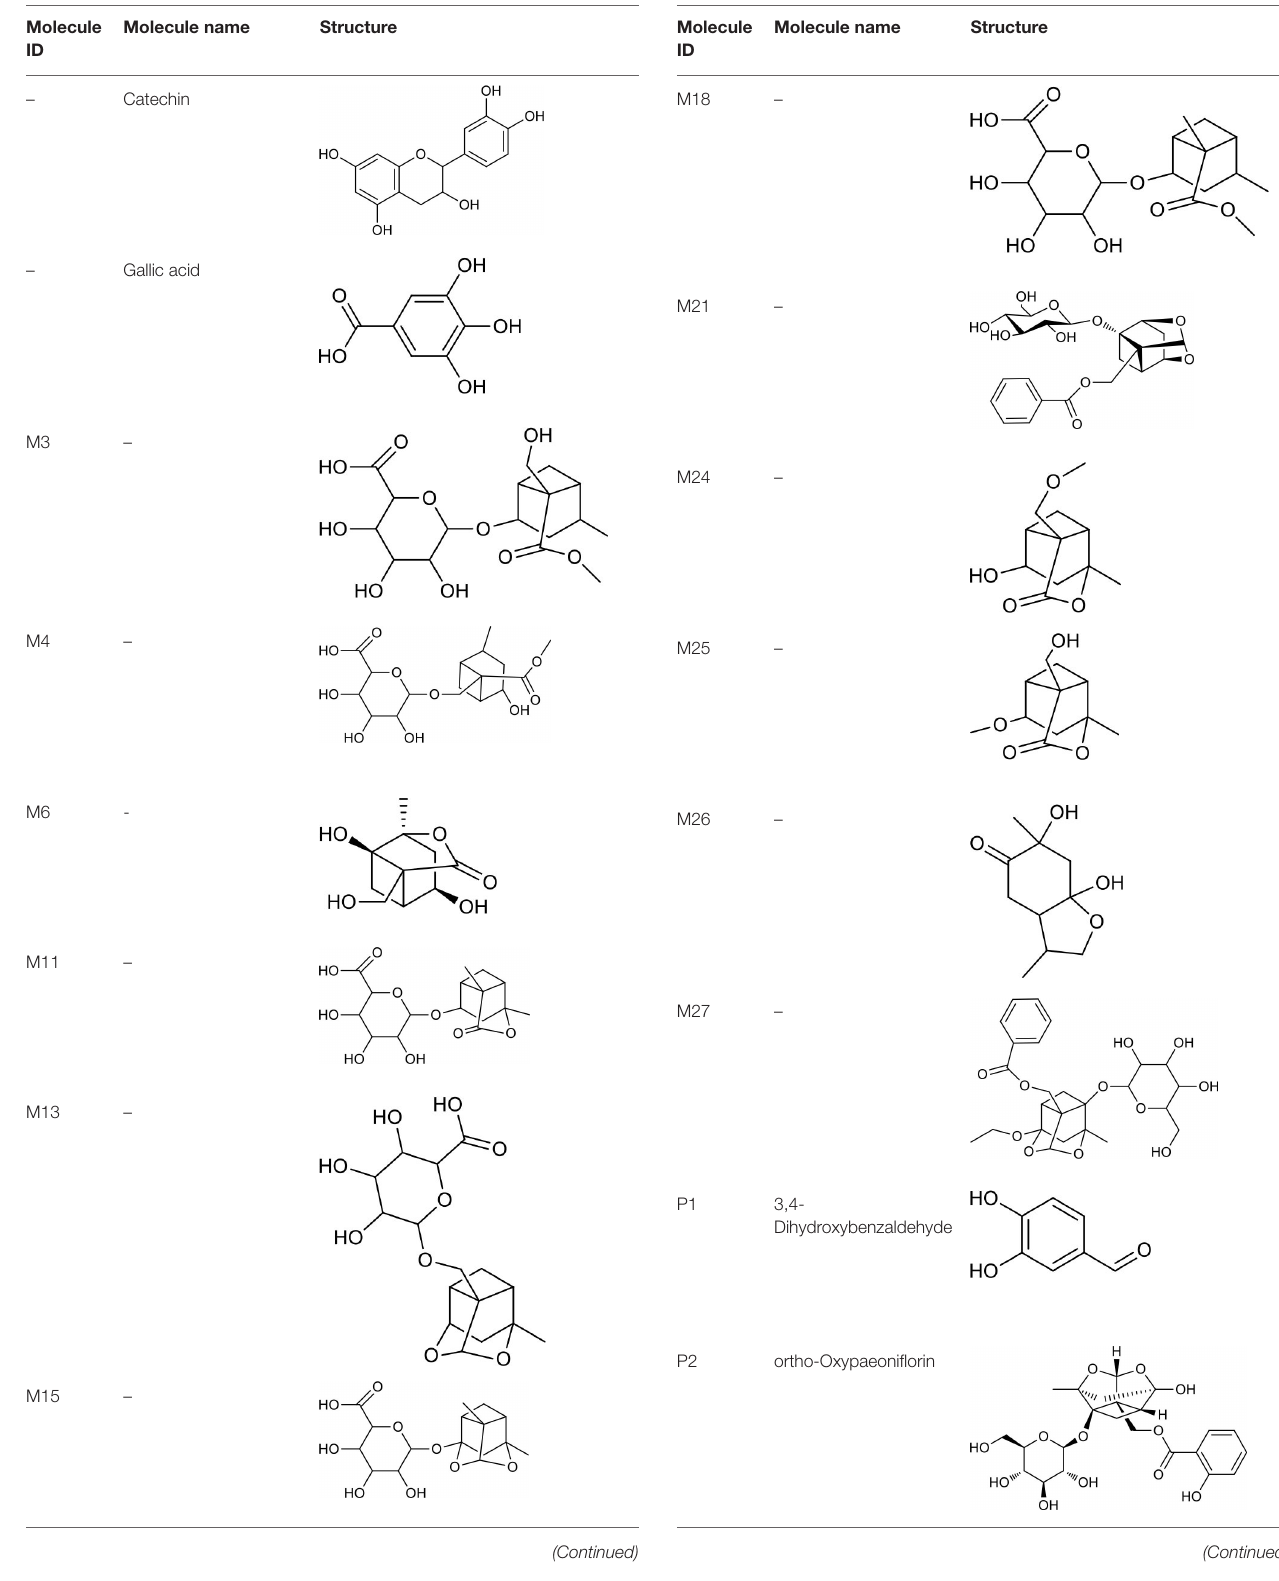
TABLE 3 | Chemical structures of components used for target